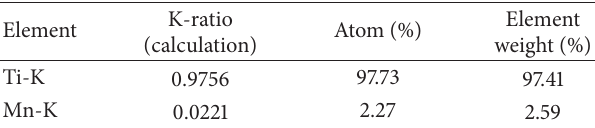
Table 3: Statistical results of metal on anatase TiO manganese by